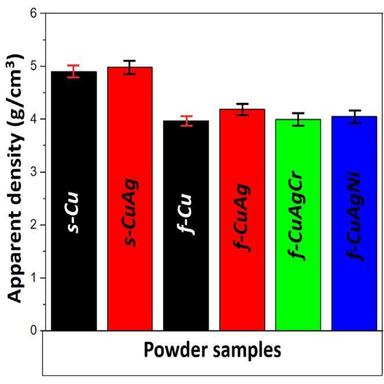
Apparent density of values of bulk materials.